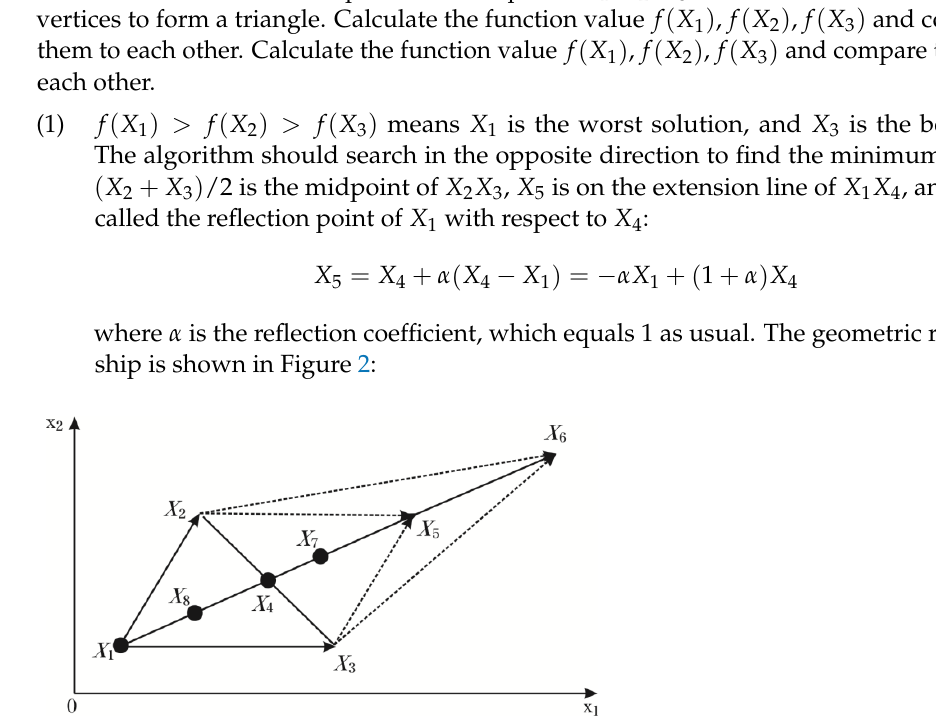
algorithm. Based on the characteristics of the iteration of ABC and the basic idea of the